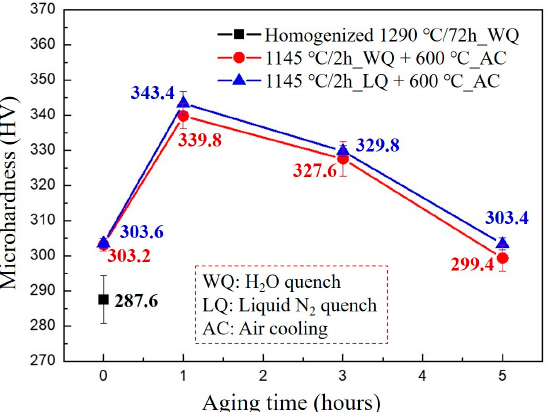
Figure 3. The effects of various aging times with different cooling methods on the hardness distribu- tion of 17-4 PH SS.